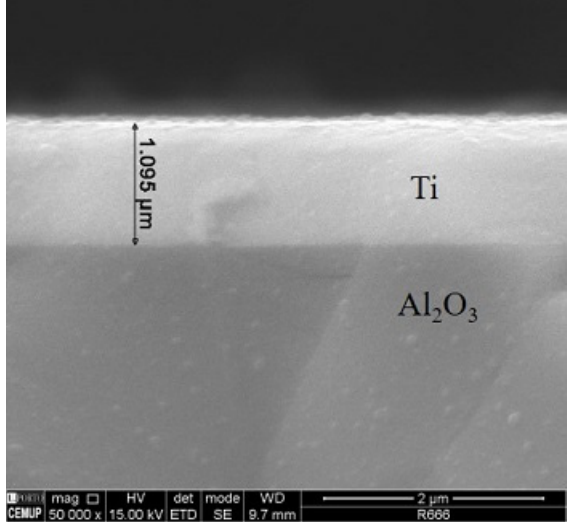
Figure 3. SEM image of the cross-section of as-deposited Ti thin film with total thickness close to 1 µm.